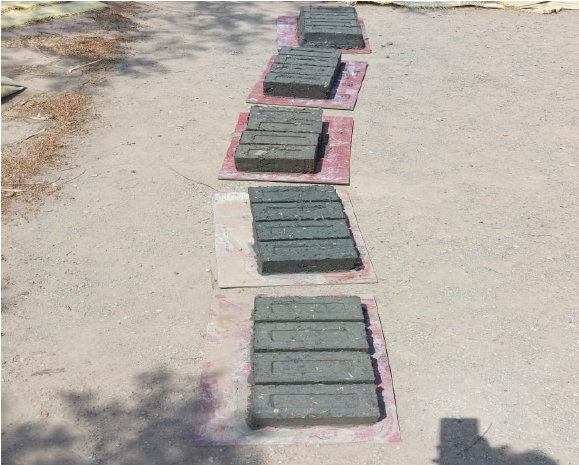
Figure 1. Admixed adobe blocks manufactured from the machine.